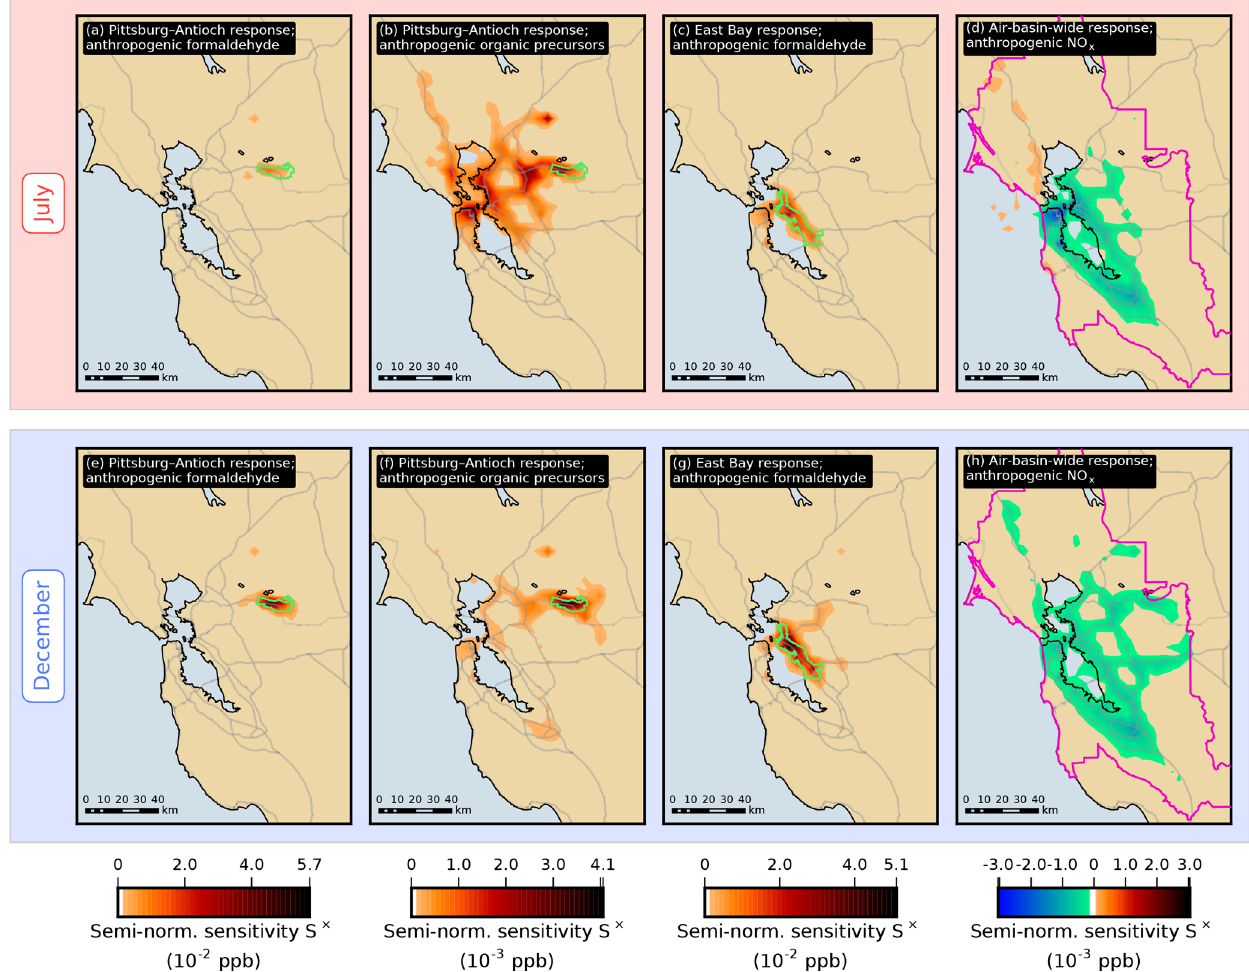
Figure 7. Semi-normalized sensitivity S × of the formaldehyde model response at different receptors to emissions of various species or groups of species. In each grid cell, sensitivity values are summed over the duration of the simulation period. The boundary of the receptor area under consideration in each case is indicated by a green or pink